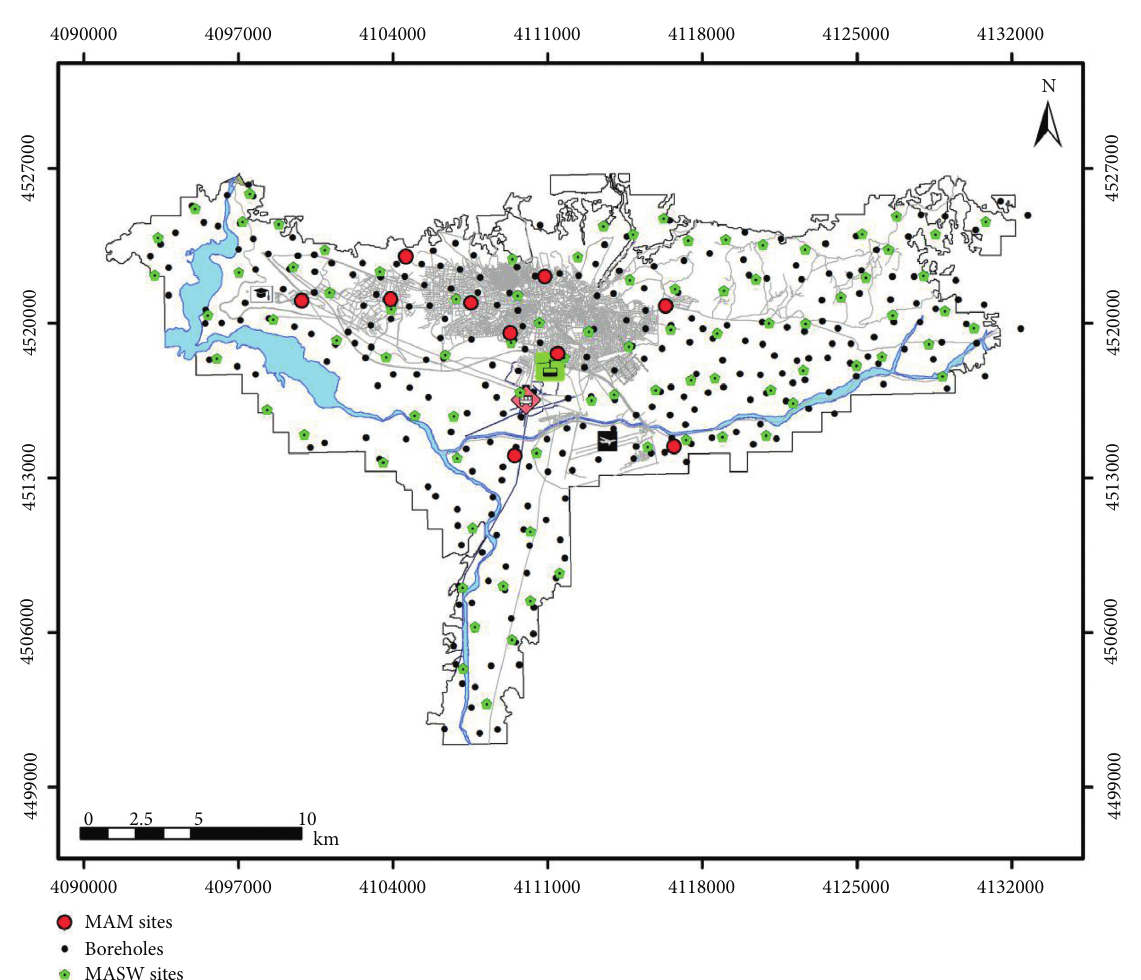
Figure 3: Locations of field tests [8,